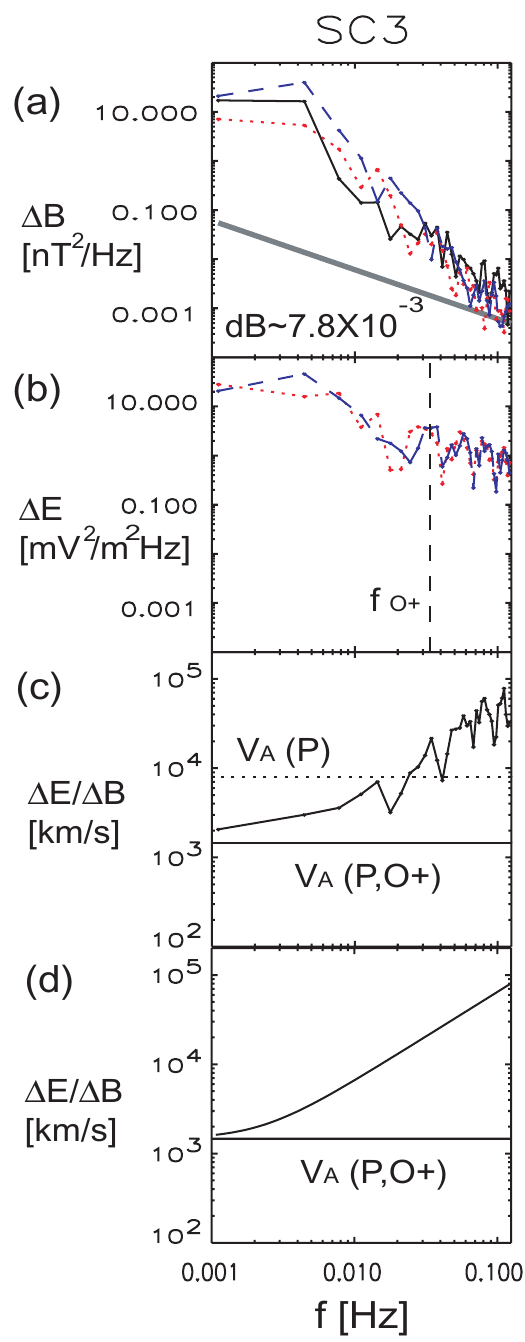
Fig. 3. (a) Wave power of magnetic field (C: black solid, RH: blue dashed, LH: red dotted) and (b) electric field plotted against the frequency. (c) Ratio of electric to magnetic field fluctuations in the unit of velocity versus frequency. Horizontal lines show the Alfv´en velocity calculated from the average | B | , N P + N O + (solid), and the average | B | , N P (dotted). (d) Solid curve shows the dispersion relation of KAW (see description in Sect. 3). All of spectra